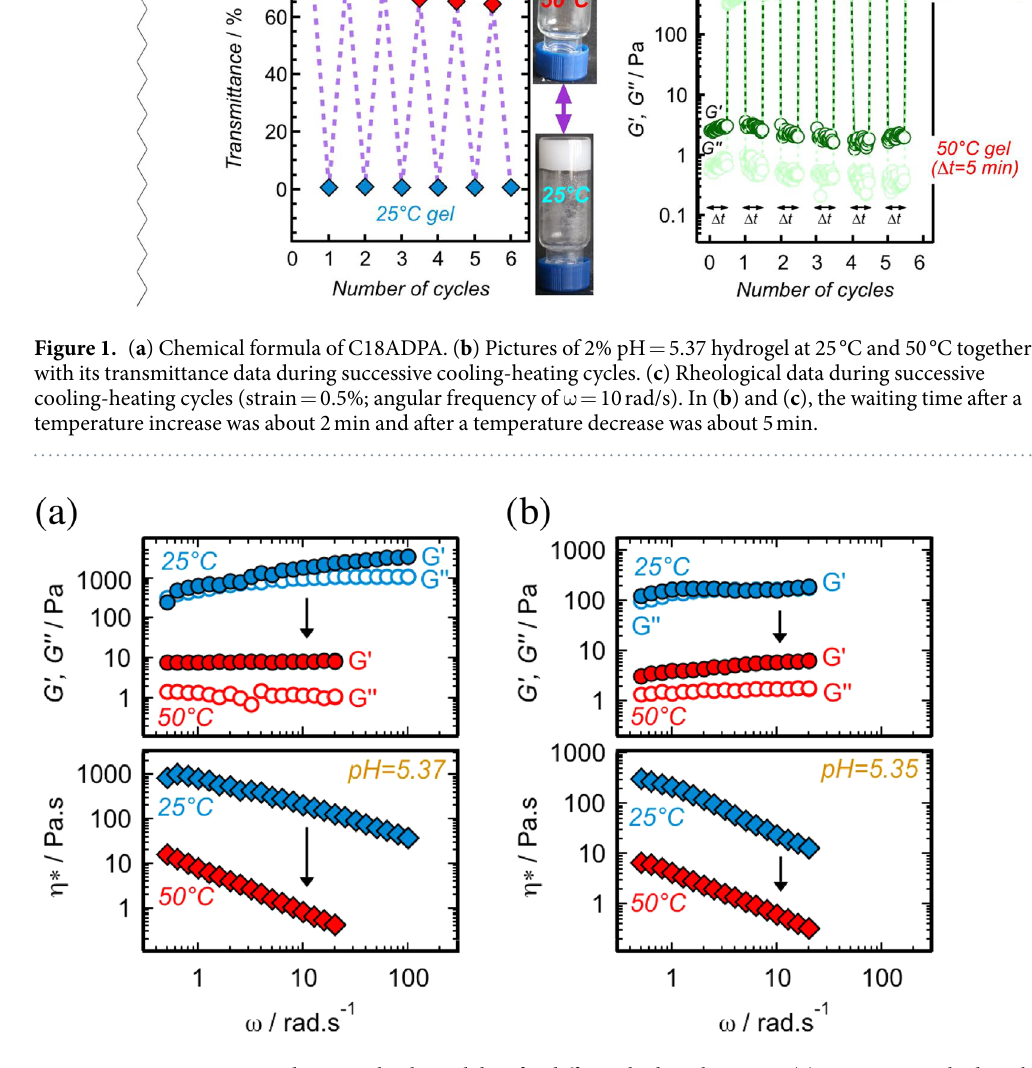
Figure 2. Frequency sweep dynamic rheological data for different hydrogel systems. ( a ) 2% pH = 5.37 hydrogel at 25 °C (strain = 0.3%) and 50 °C (strain = 2%), and ( b ) 2% pH = 5.35 hydrogel at 25 °C and 50 °C (strain =